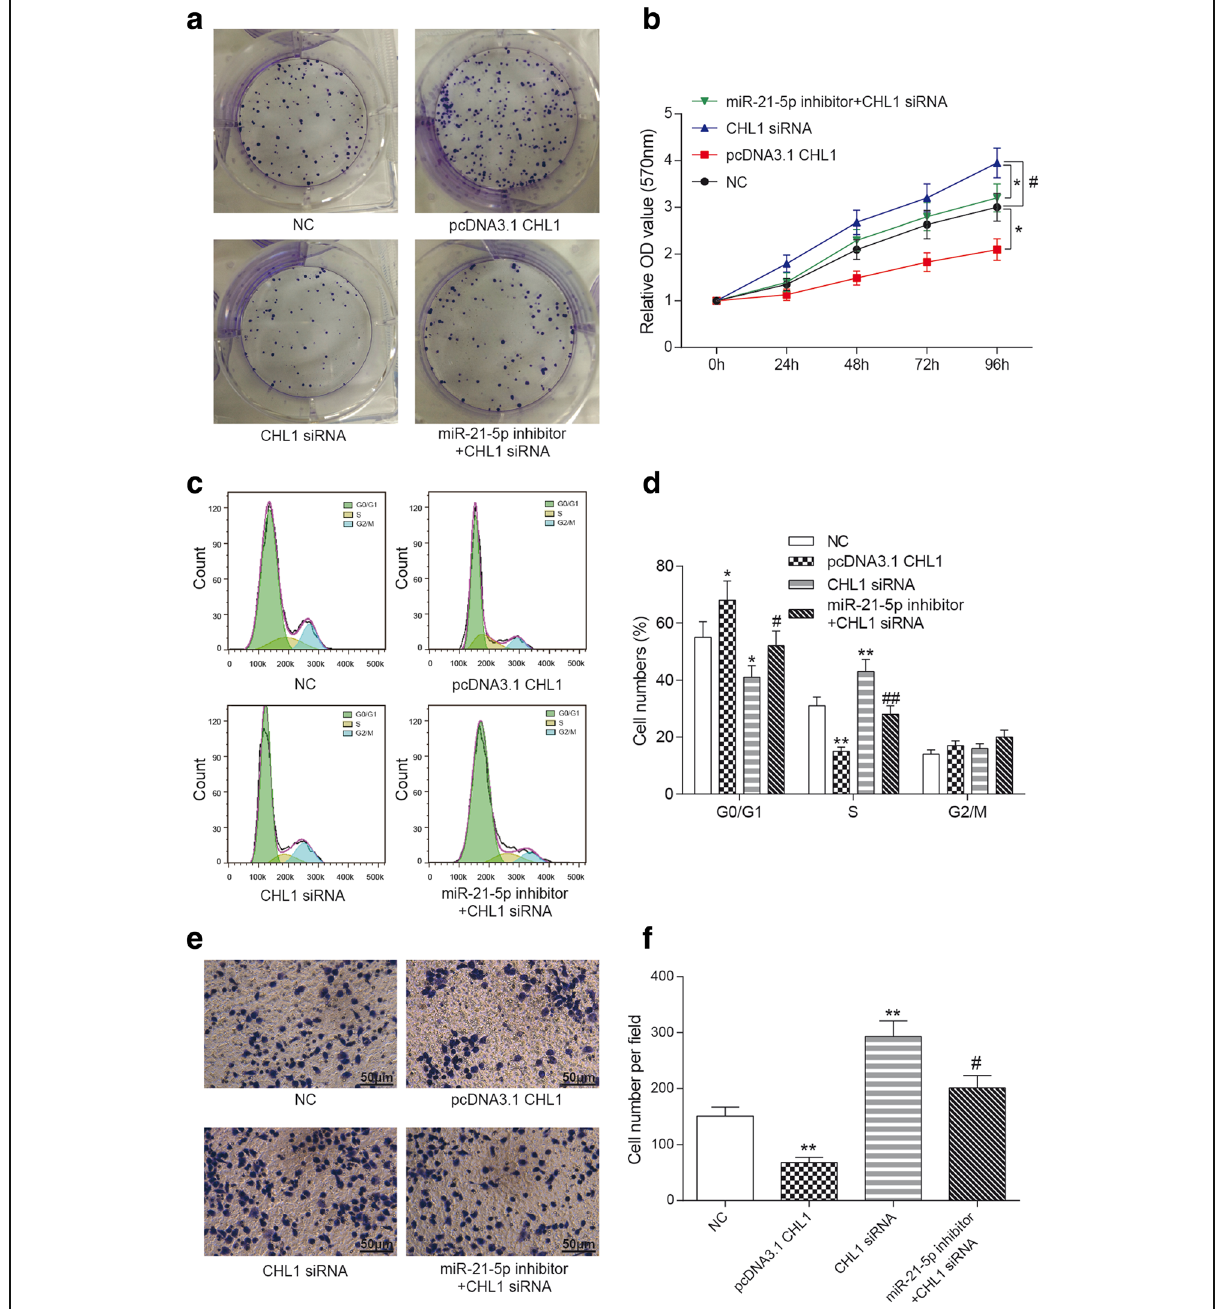
Fig. 7 CHL1 inhibited COAD cells development. a Colony formation assay indicated that CHL1 suppressed COAD cells growth. b MTT assay revealed that overexpression of CHL1 inhibited cell viability, while knockdown of CHL1 enhanced the proliferation ability of COAD cells. c , d The result of flow cytometry suggested that CHL1 arrested cell cycle in G0/G1 phase, while deletion of CHL1 increased cells in S phase. e , f Transwell assay was performed to detect invasion ability. The cell number in pcDNA3.1 CHL1 group was increased, while that in CHL1 siRNA group was decreased compared with control group. The scale bar was 50 μ m. * P < 0.05, ** P < 0.01, compared with NC group. # P < 0.05, ## P < 0.01, compared with CHL1 siRNA